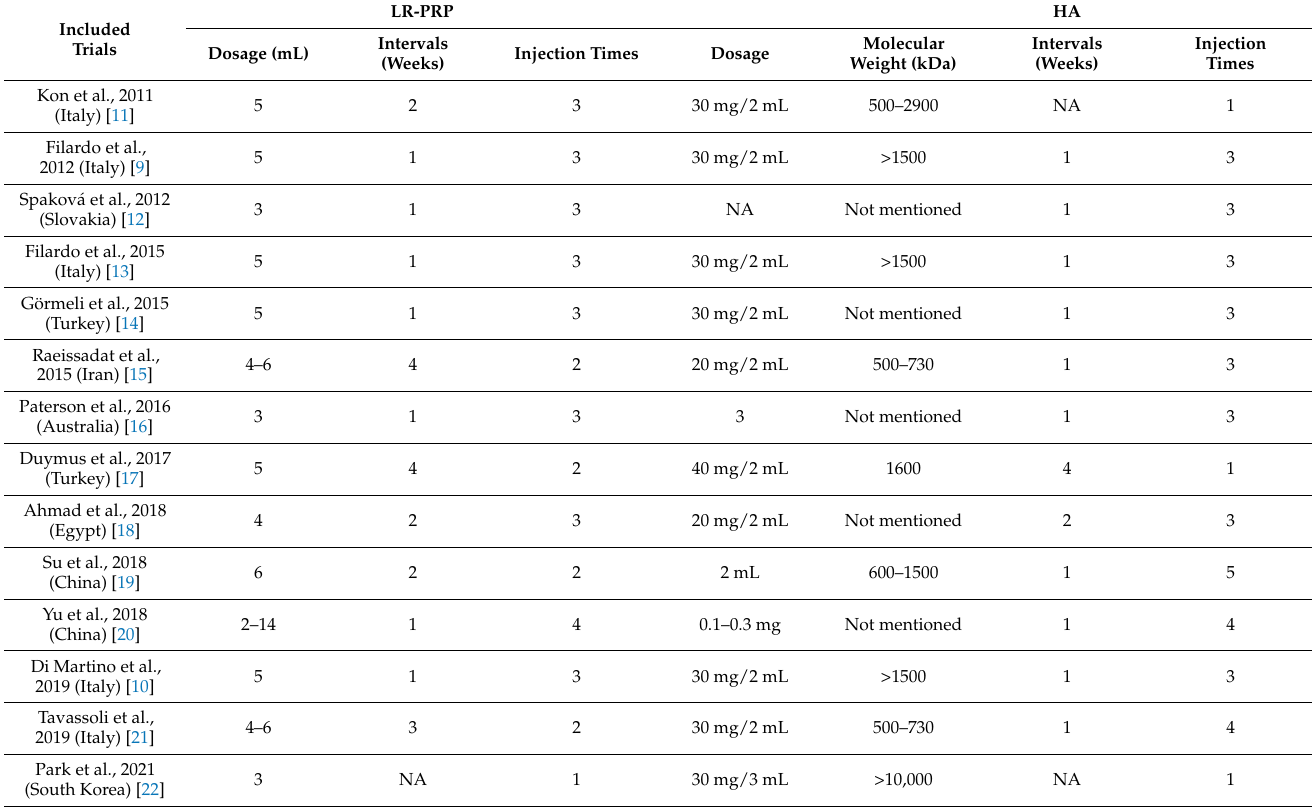
Table 2. The treatment protocols of IA LR-PRP and IA HA